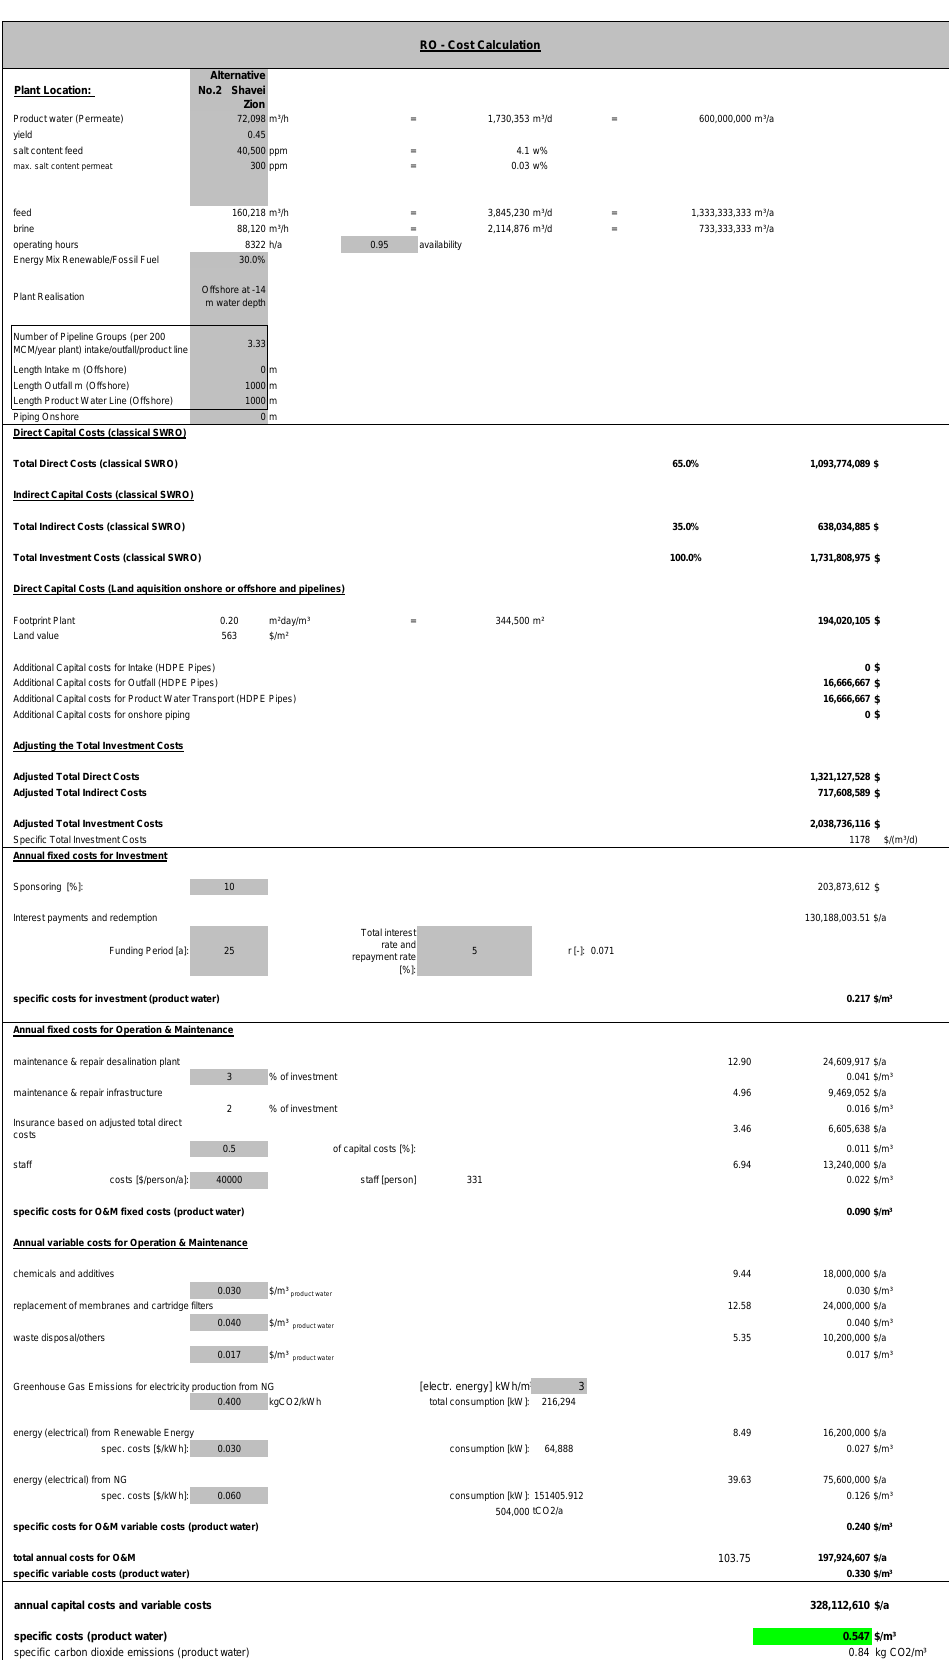
Figure A3 Detailed cost table for the economic analysis — Alternative No. 2. Figure A3. Detailed cost table for the economic analysis—Alternative No.